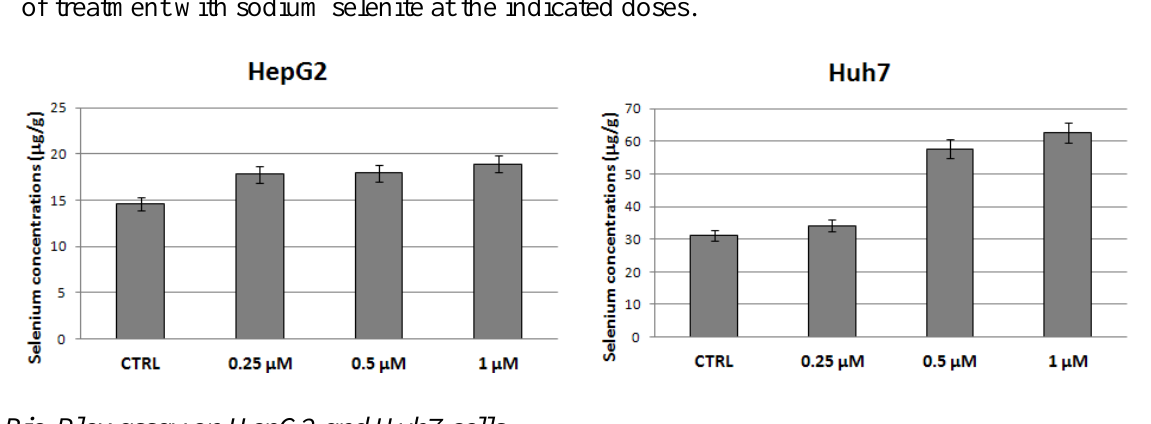
Figure 4. Selenium concentrations (μg/g) in protein extracts of HepG2 and Huh7 after 24 h of treatment with sodium selenite at the indicated